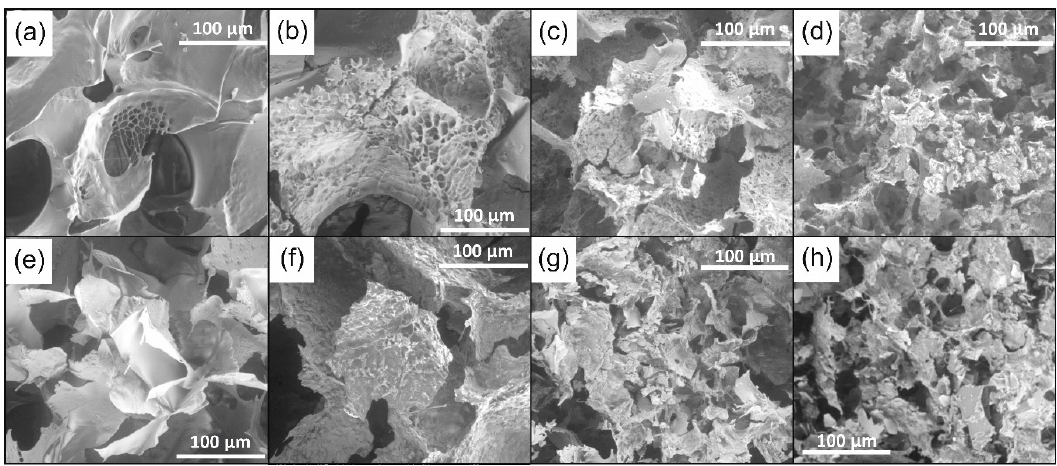
Figure 9. Microscopic images of chitosan scaffolds at 500× magnification: ( a ) sample 1, ( b ) sample 3, ( c ) sample 4, ( d ) sample 5, ( e ) sample 1CC, ( f ) sample 3CC, ( g ) sample 4CC, and ( h ) sample 5CC.